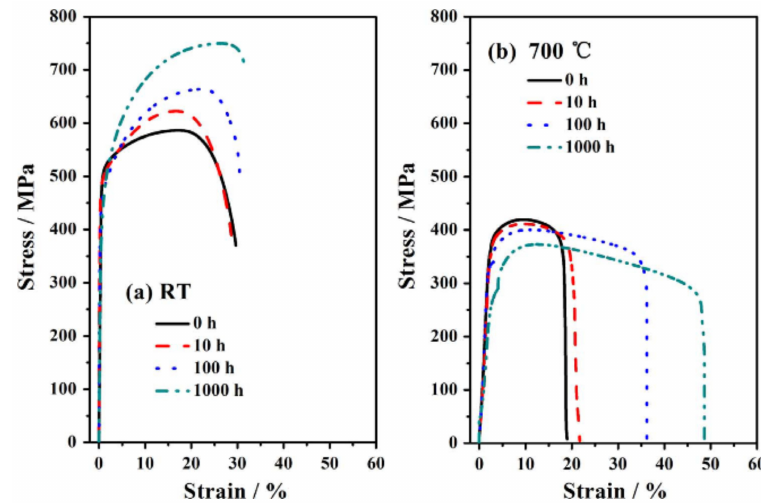
Figure 12. ( a ) Stress–strain curves at RT and ( b ) 700 ◦ C [29].